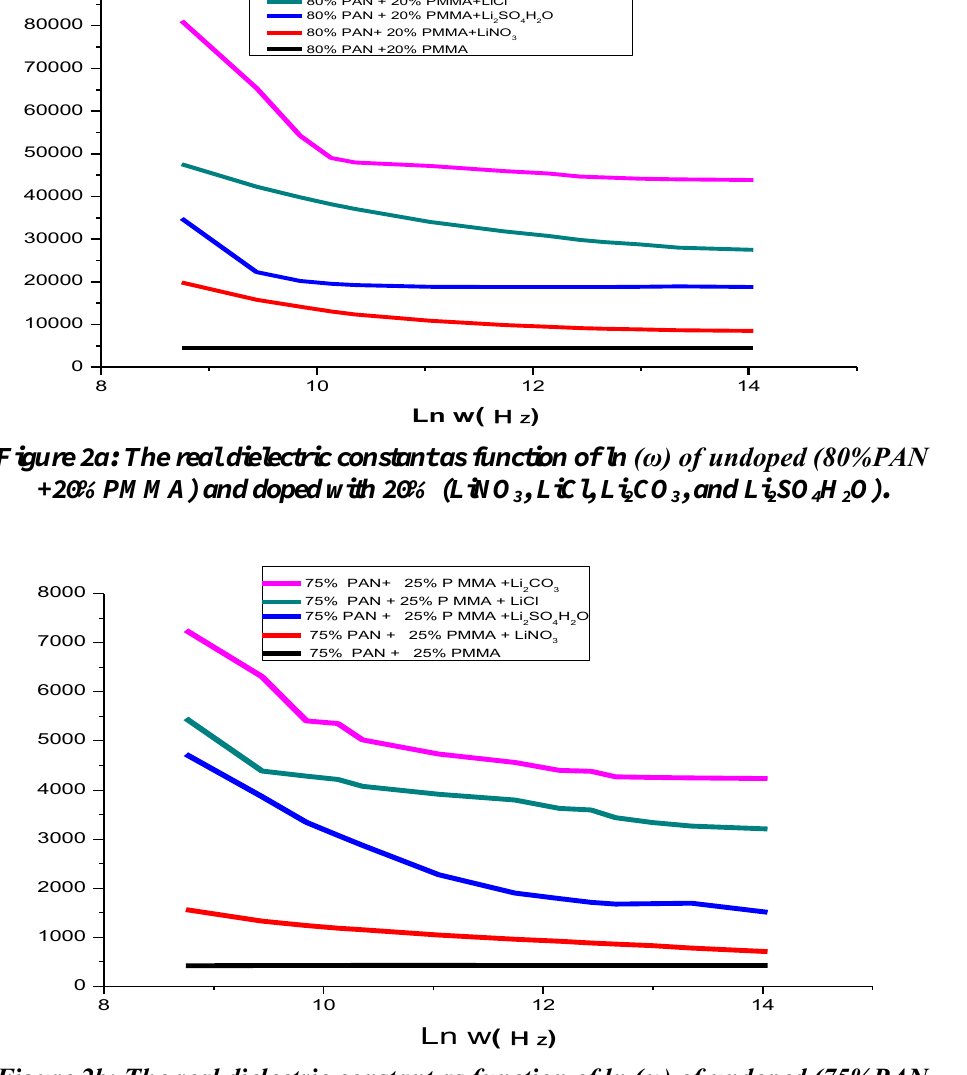
Figure 2b: The real dielectric constant as function of ln (ω) of undoped (75%PAN +25%PMMA) and doped with 20% (LiNO